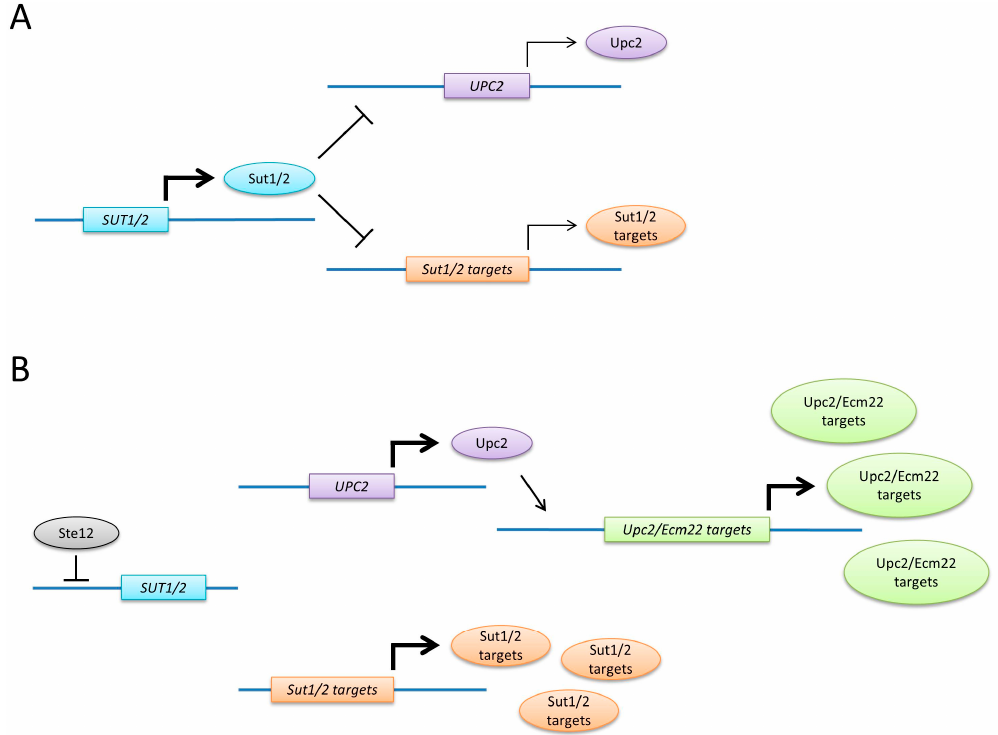
Figure 6. Transcriptional regulation of filamentation. ( A ) Under nutrient-rich conditions, SUT1 and SUT2 are expressed and partially repress UPC2 and target genes that have a role in filamentation; ( B ) when cells grow on a semisolid medium with limited nutrients, Ste12 becomes activated, which represses SUT1 and SUT2 . This results in induction of the Sut1/Sut2 target genes including UPC2 , which in turn leads to increased expression of Ecm22/Upc2 targets. The combined action of increased levels of Sut1/Sut2 and Ecm22/Upc2 targets might then trigger a switch to filamentous growth. Arrows indicate induction of gene expression, T-bars represent repression.